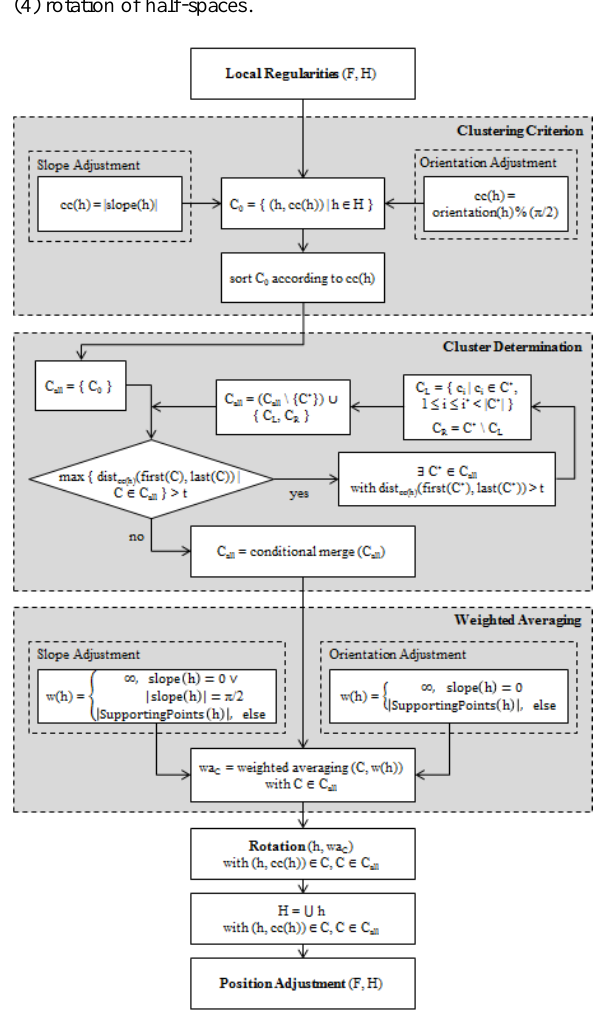
Figure 4. The local half-space adjustment process (F = set of features, H = set of half-spaces, C = cluster of half- spaces. t = threshold for cluster